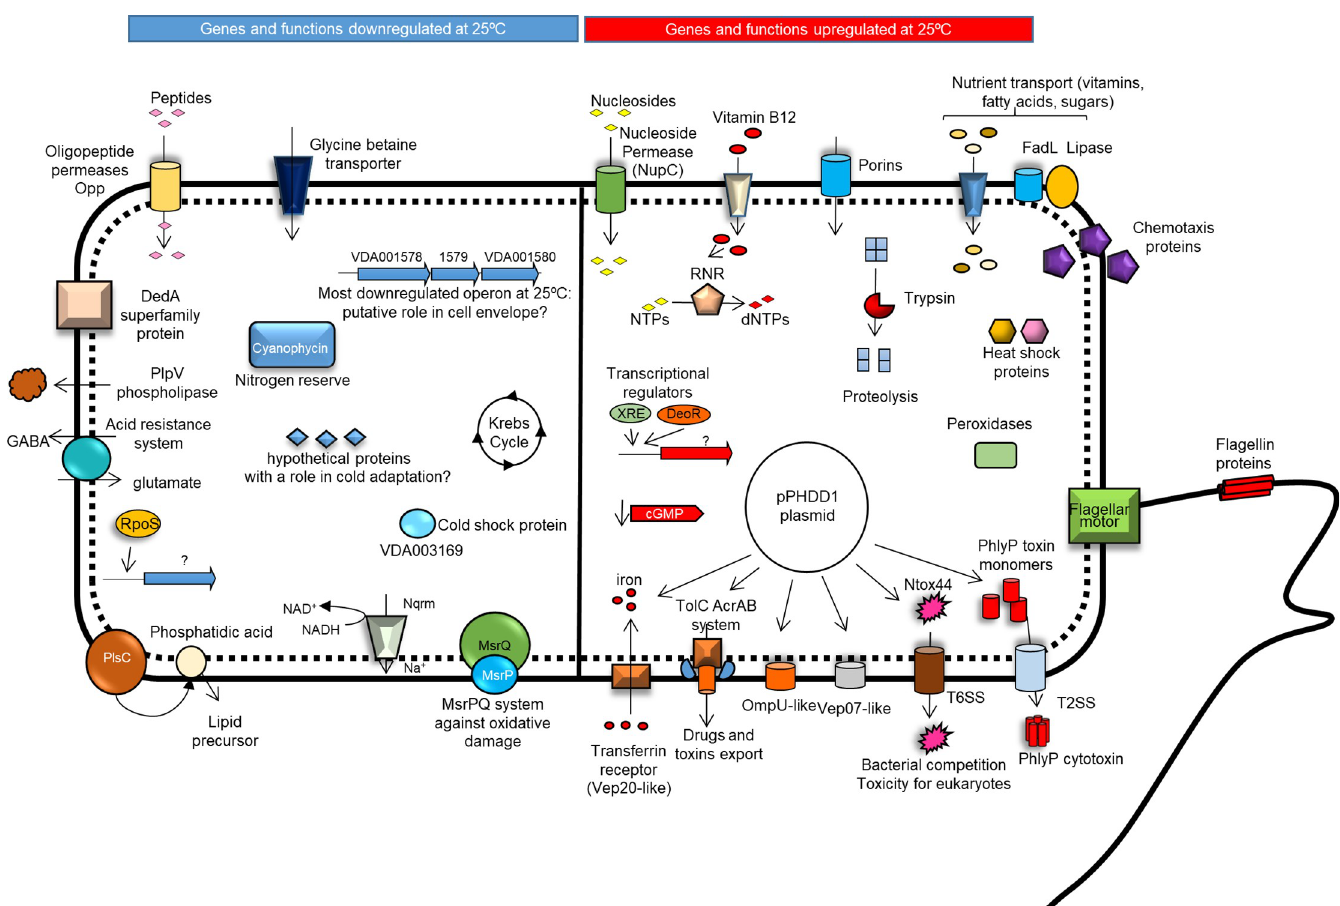
Fig 6. Diagrammatic summary of genes upregulated (right side) and downregulated (left side) at 25˚, relative to 15˚C, in Pdd . Growth at 25˚C upregulated motility and chemotaxis-related functions, as well as nutrient uptake and utilization genes. Potential virulence factors encoded within pPHDD1 plasmid were also upregulated at 25˚C. Genes with lower expression at 25˚C include a number of gene operons of yet unknown function, functions related to cell envelope, rpoS , and specific amino acid biosynthesis routes, among others. This diagram has been constructed based on transcriptomic data, and further studies are needed to establish the proposed